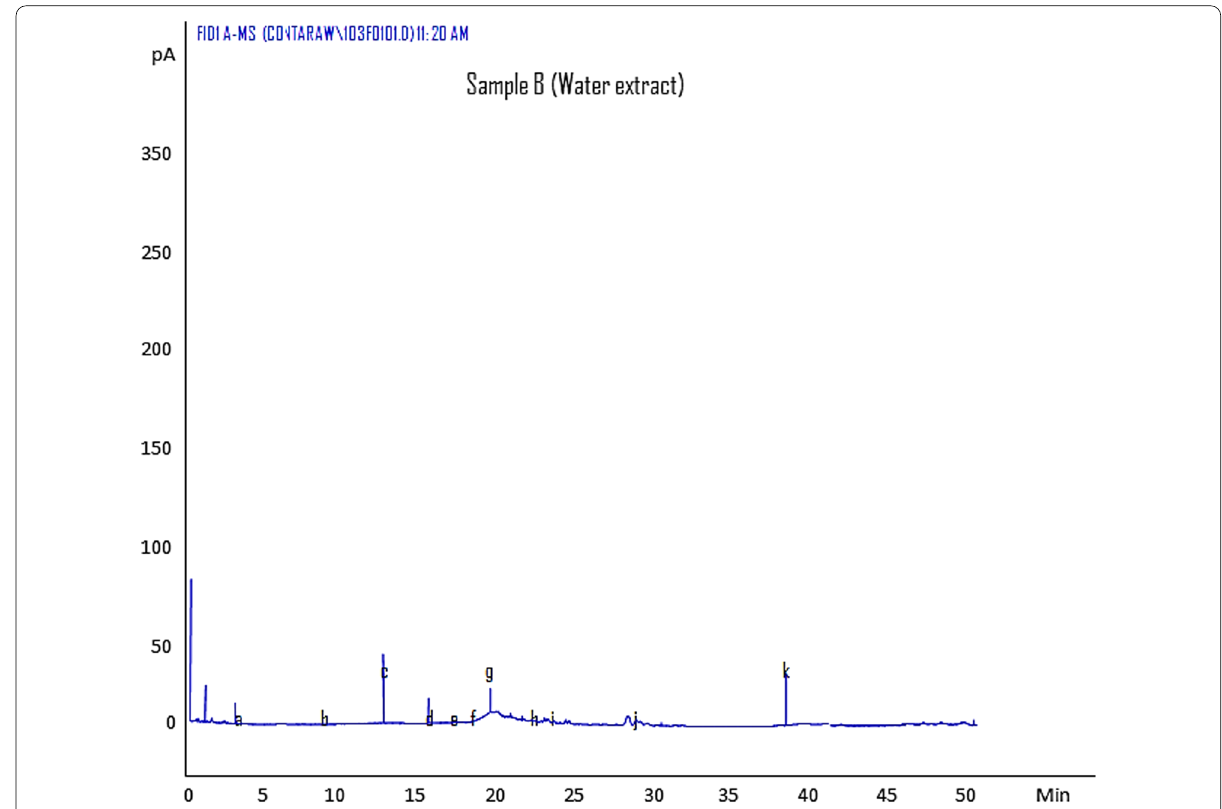
Fig. 2 Gas chromatography–mass spectroscopy chromatogram of Moringa oleifera leaf aqueous extract